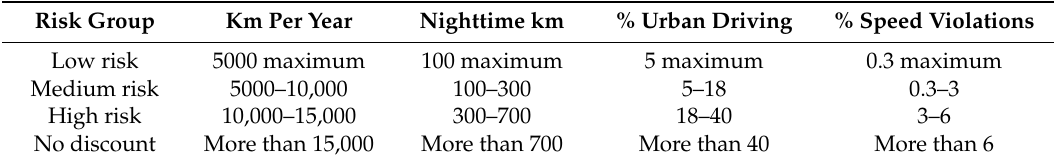
Table 5. Risk groups.